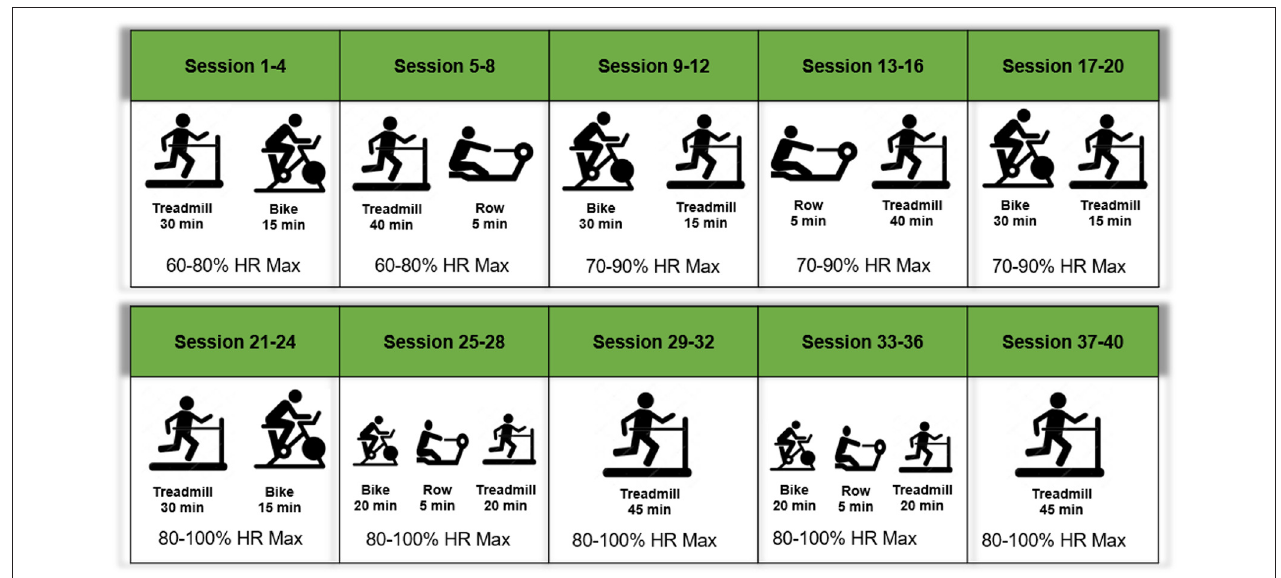
FIGURE 3 | Overview of the exercise intervention.